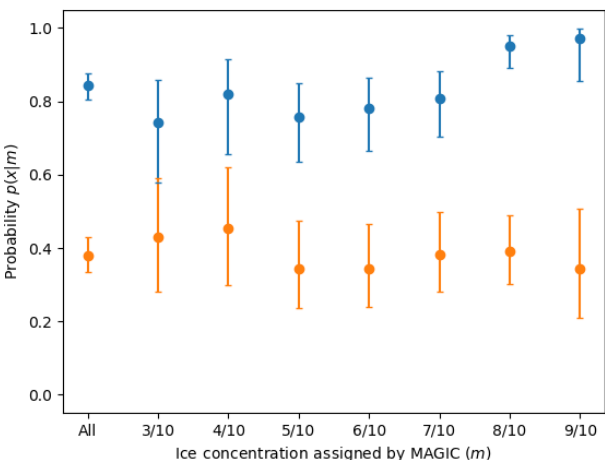
Figure 19. The producer’s accuracy, or probability p(x | m) . The orange values show the probability that an analyst assigned an ice concentration value that exactly matched MAGIC, e.g. p(x = 1 | m = 1 ) . The blue values show the probability that the analyst as- signed an ice concentration within ± 1 category of MAGIC, e.g. p(x = 3 , 4 , 5 | m = 4 ) .